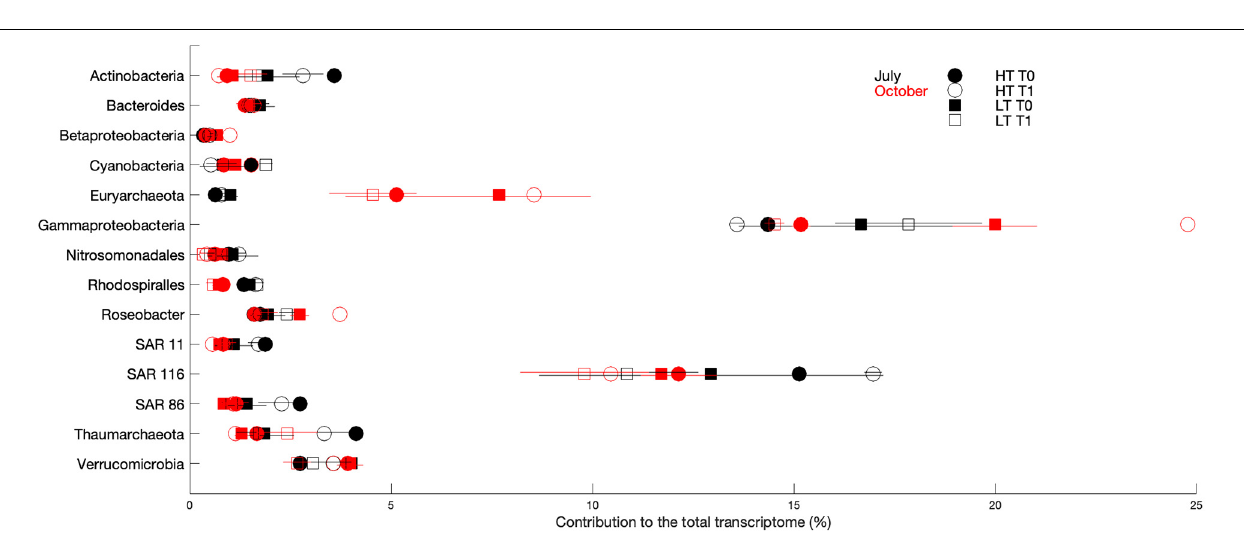
FIGURE 6 | Percent contribution to the total transcriptome for the 50 highest transcript-recruiting reference genomes categorized by taxonomic group. Black and red symbols represent July and October, respectively. Solid and open symbols represent T0 and T1, respectively. Circle and square symbols represent high tide and low tide, respectively. In some cases, error bars are smaller than symbols.